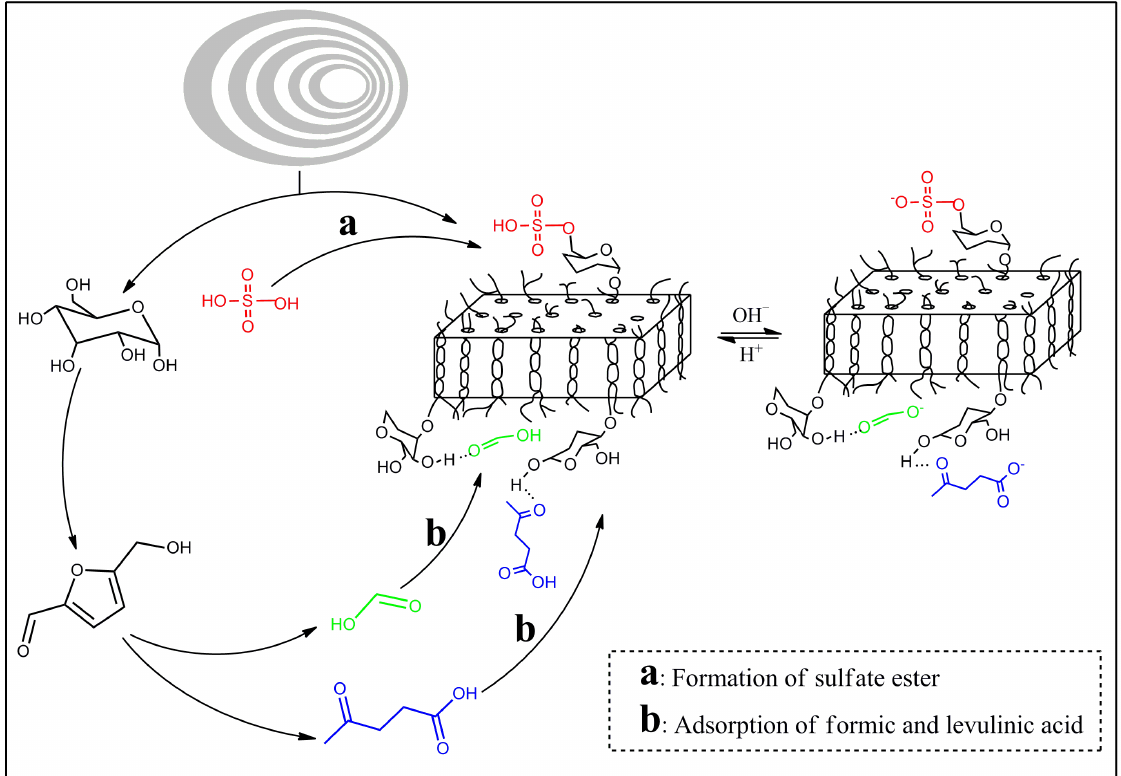
Figure 5. Formation of sulfate esters and adsorption of formic and levulinic acids on the surface of SNC (a: Formation of sulfate ester, b: adsorption of formic and levulinic acids).